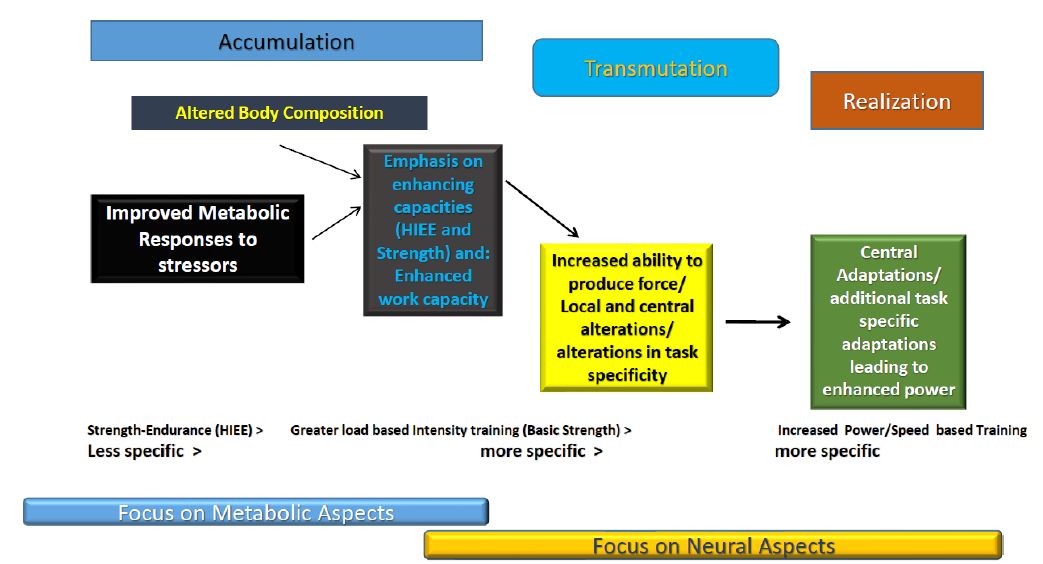
Figure 4. Sequential Phase Based Approach to Metabolic and Neural